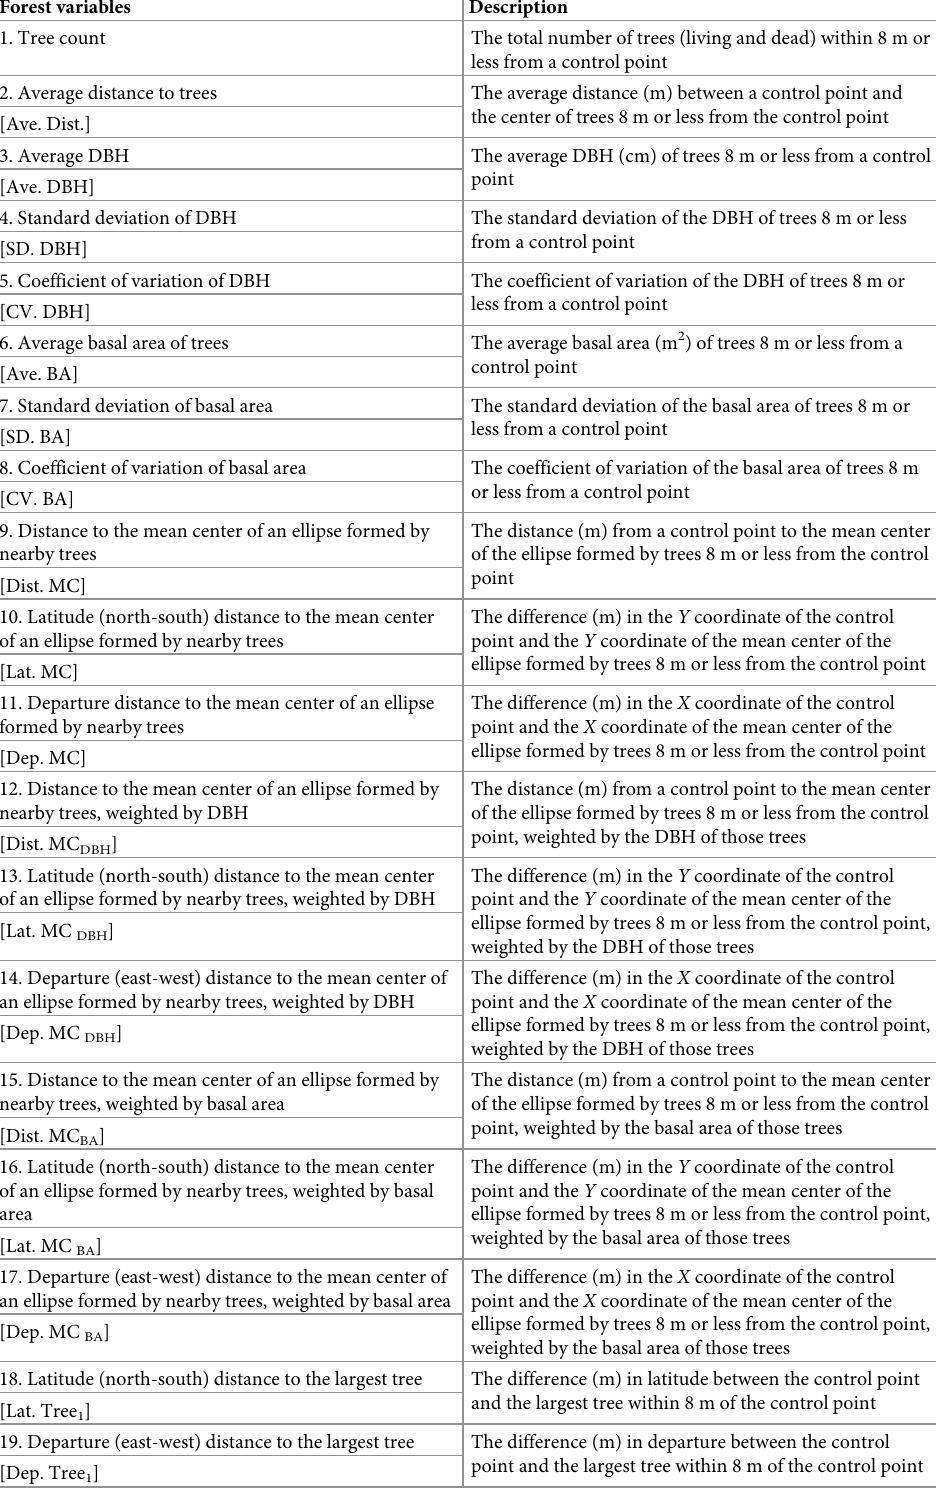
Table 1. A summary of forest variables used in the correlation